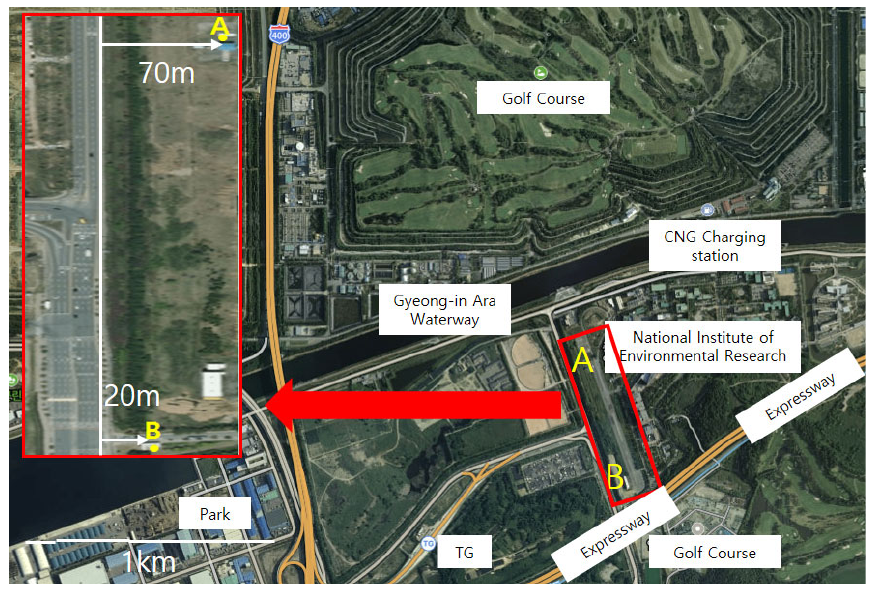
Figure 1. The aerial image of the sampling site for investigating the emission characteristics of TRWP according to the roadside separation distance (http://map.naver.com (accessed on 20 July 2022)).